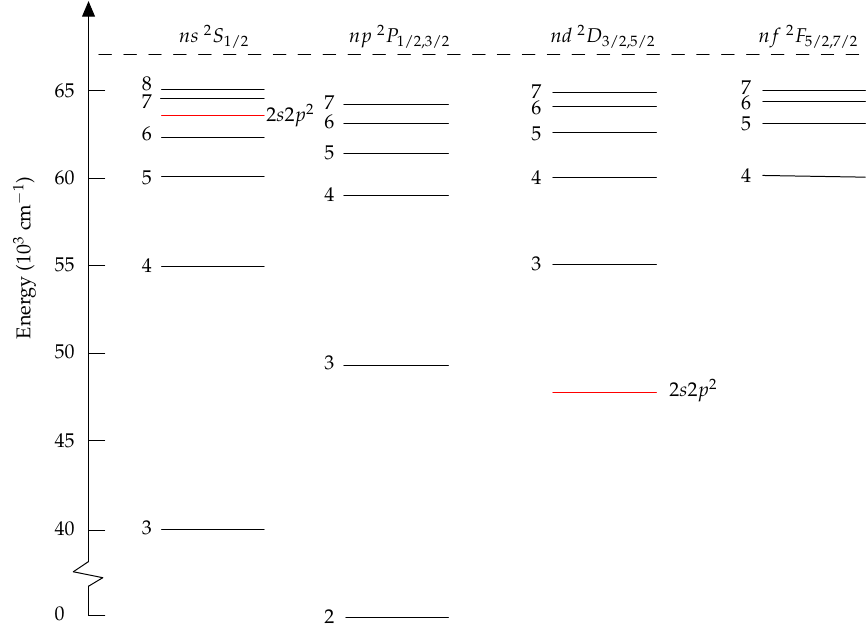
Figure 1. Energy-level diagram for neutral boron. The 2 s 2 p 2 2 S 1/2 perturber is embedded in the ns 2 S 1/2 Rydberg series, with high impact on the lifetimes of the nearby